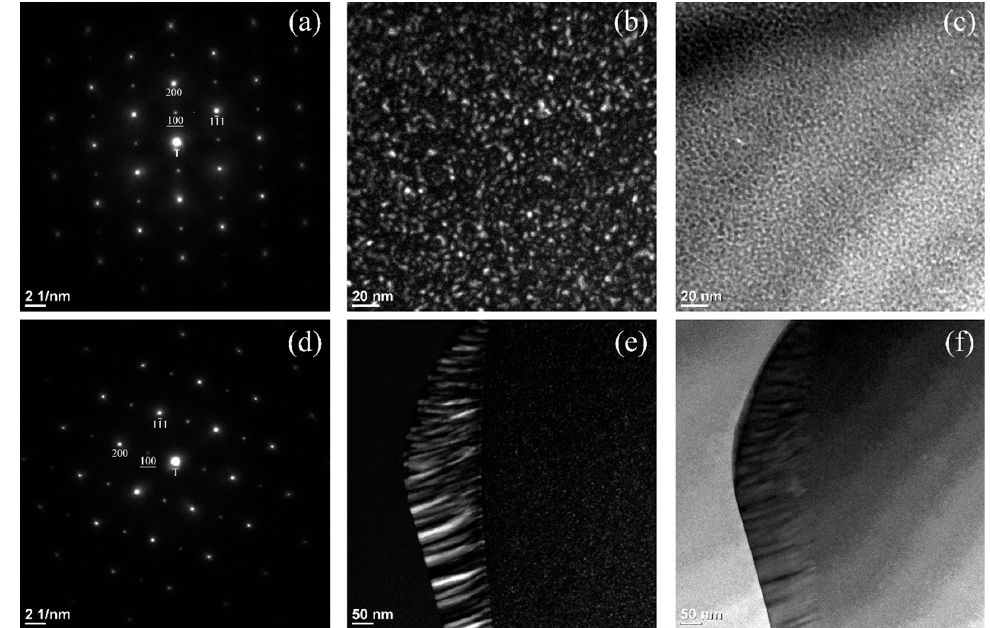
Figure 3. The TEM analysis of the HEA with the same heat treatment as Figure 2: ( a ) [011] SADP taken from the FCC matrix; ( b ) DF image taken from the L1 2 (100) reflection in ( a ); ( c ) the BF image corresponding to the DF image in ( b ); ( d ) [011] SADP taken from the lamellae at the grain boundary; ( e ) the DF image taken from the L1 2 (100) reflection; and ( f ) the BF image corresponding to ( e ). In addition to the homogeneous precipitation of the fine L1 2 particles in the FCC grains, grain-boundary precipitates not only appear in the form of separate grains, but also as colonies from the SEI observation, as shown in Figure 2b. The TEM investigation